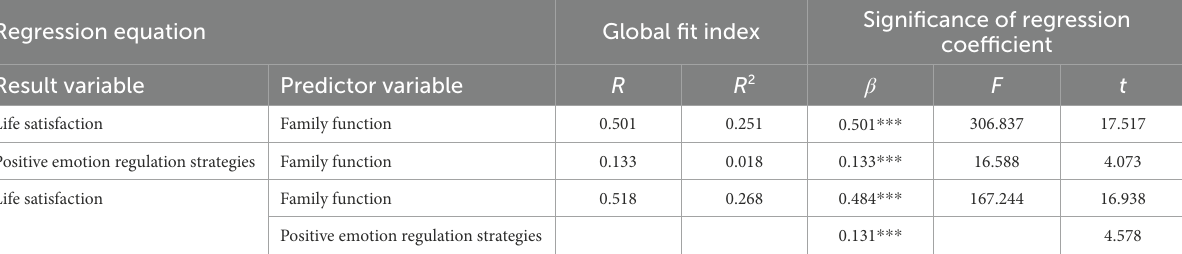
TABLE 6 Regression analysis of the relationship between family function, positive emotion regulation strategies, and life